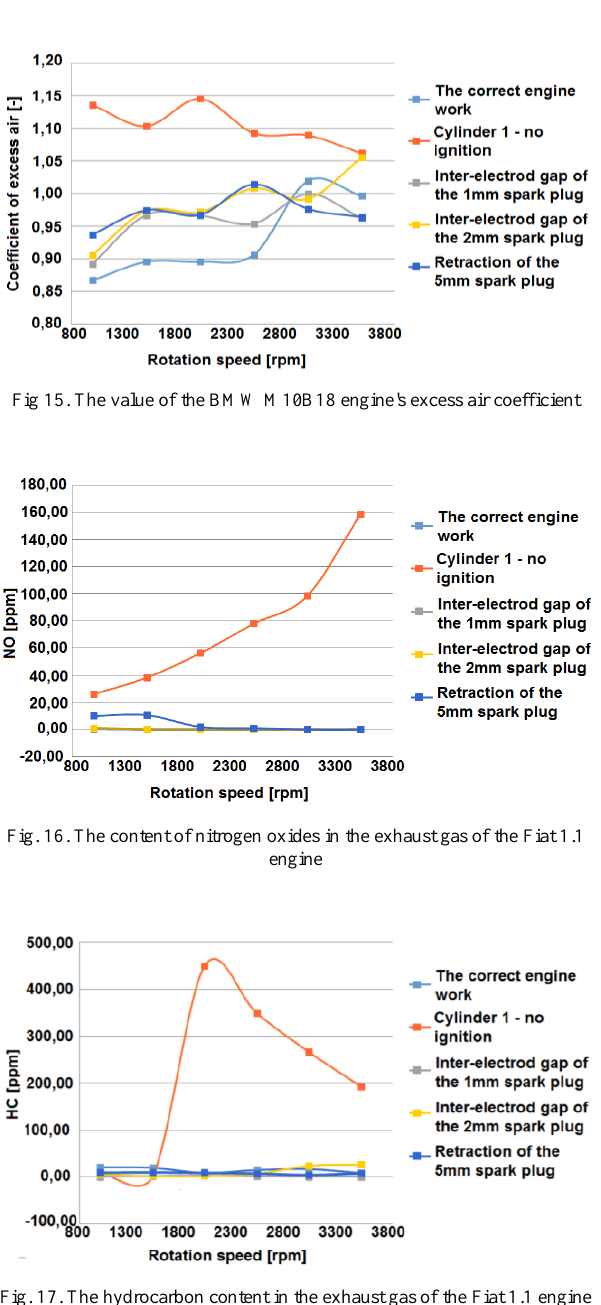
Fig. 17. The hydrocarbon content in the exhaust gas of the Fiat 1.1 engine